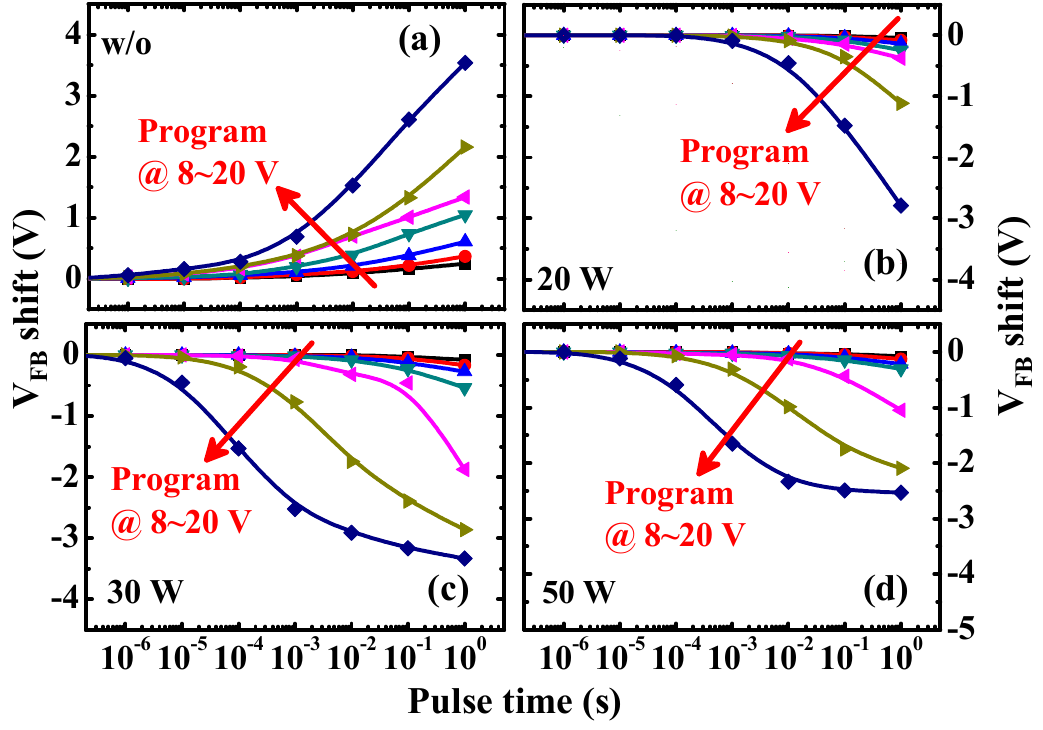
Figure 3. Programming characteristics of ( a ) w/o; ( b ) 20 W; ( c ) 30 W; and ( d ) 50 W samples with different pulse widths of V g − V FB of 8, 10, 12, 14, 16, 18, and 20 V. The pulse widths were in the range of 1 μ s to 1 s. The V FB shift towards the positive and negative directions was observed for the Au-NP NVMs without and with low-damage CF 4 plasma treatment on the BO layer, respectively.